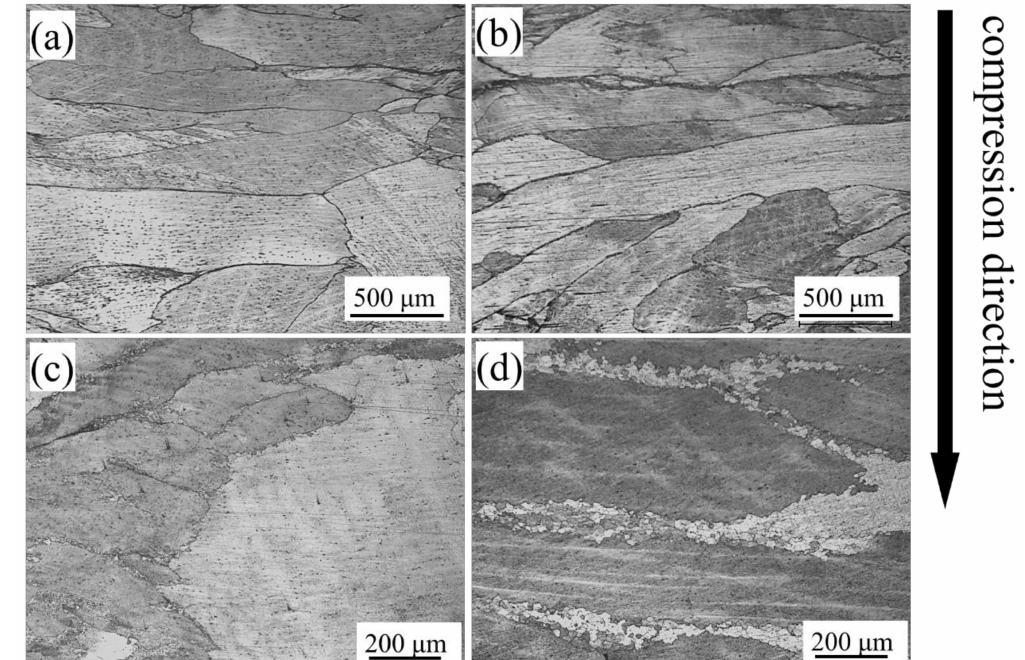
Figure 5. Optical microscopy (OM) images of the alloy deformed at 800 ◦ C with a strain rate of ( a ) 1 s − 1 , ( b ) 0.1 s − 1 , Processes 2021 , 9 , x FOR PEER REVIEW ( c ) 0.01 s − 1 , and ( d ) 0.001 s − 1 .